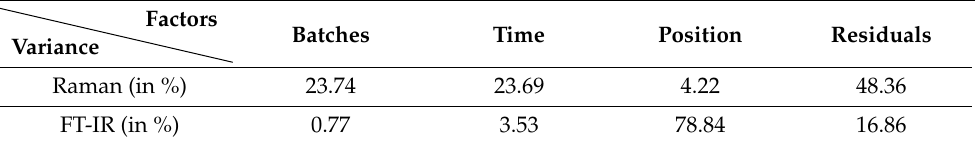
Figure 4. PCA analysis of Raman (first row) and FT-IR spectra (second row) collected from ( A , B ) inner region and ( C , D ) outer-ring regions from the plasma of the HF patient ( n = 1). (E , F ) combined analysis of the vibrational spectra collected from both inner and outer-ring regions. The principal components 1 and 2 of ( G ) Raman and ( H ) FT-IR data. The different time points (TP1 to TP3) of the patient sample collection are color coded, and the experimental replicates are presented as symbols (+, ∆ and o). Table 1. Variance analysis of different factors from the plasma of the HF patient ( n =